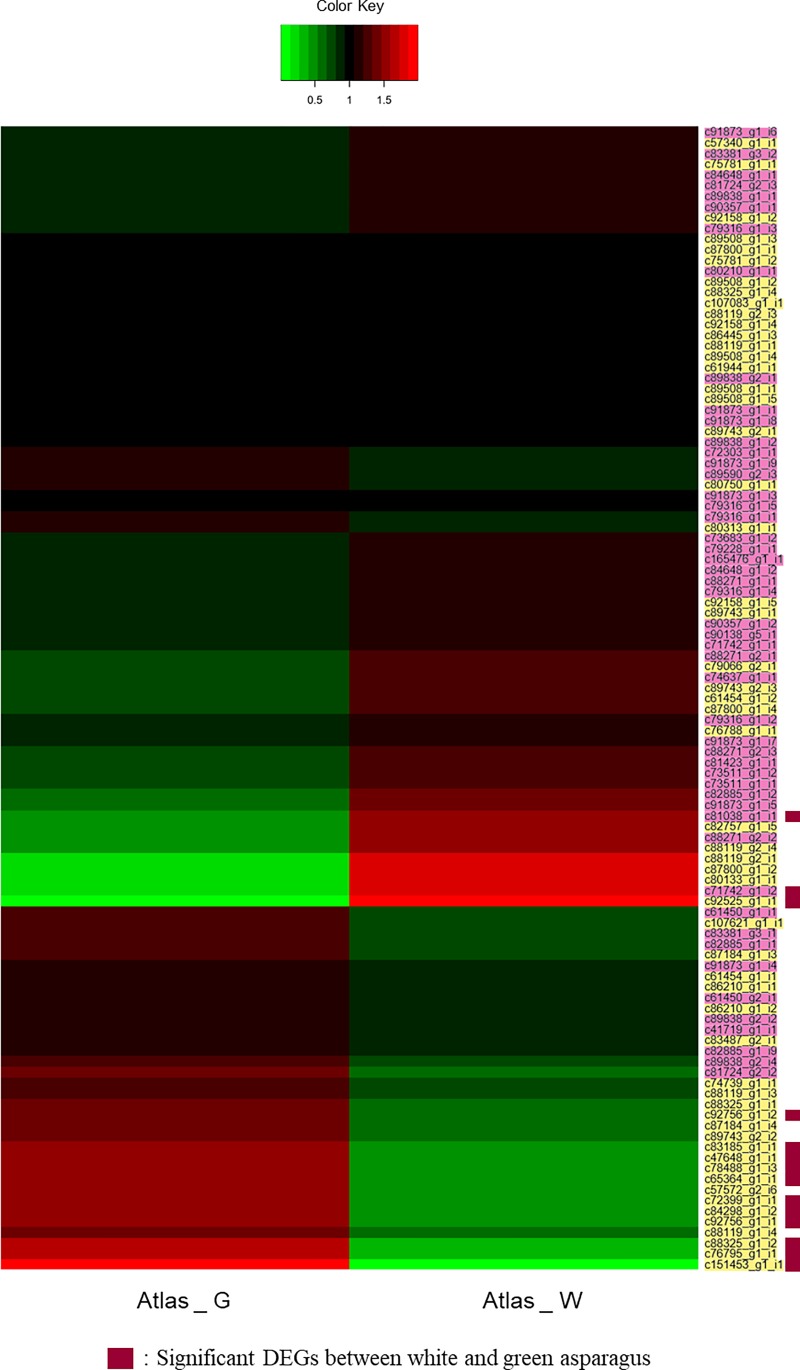
Heat map of expression differences in 57 flavonoid and 50 terpenoid biosynthesis genes of asparagus based on FPKM values (names in yellow represent flavonoid-related genes and names in pink represent terpenoid-related genes).